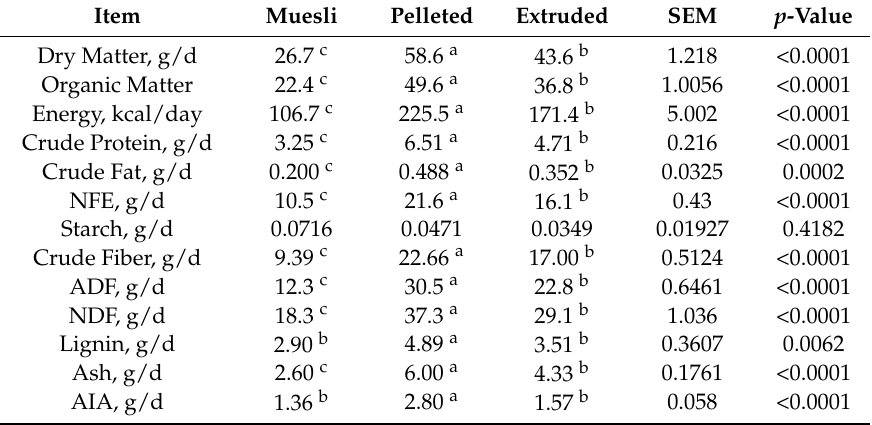
Table 3. Fecal output on dry matter basis of rabbits fed muesli, pelleted, or extruded dietary treatments.